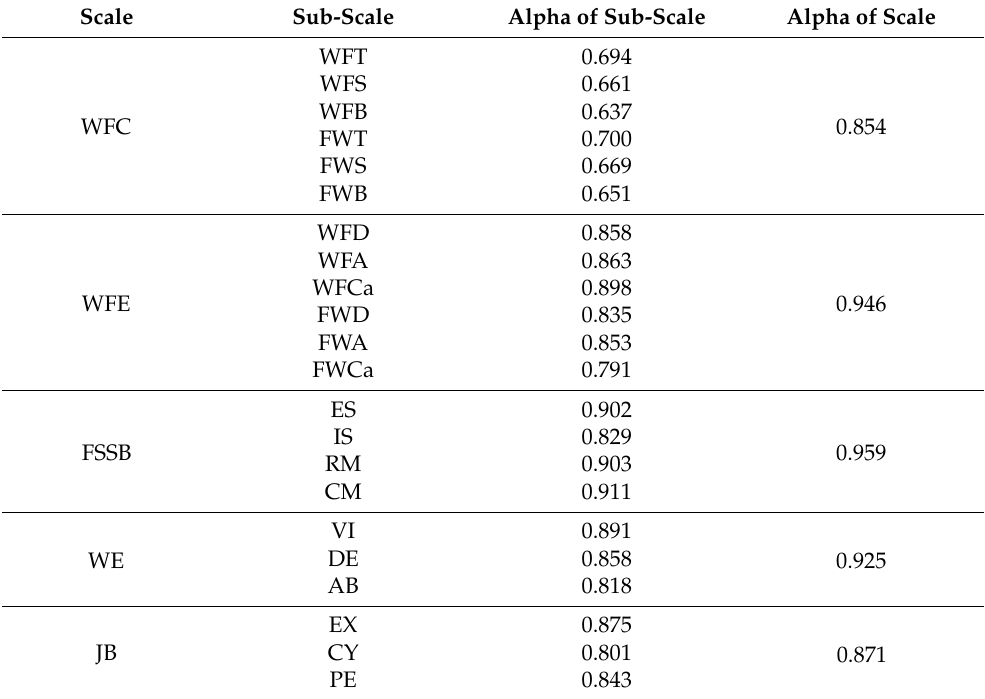
Table 3. Internal